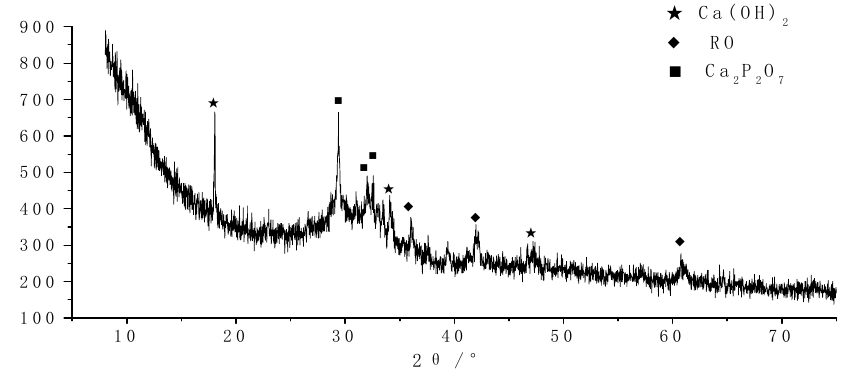
Figure 4. XRD diagram of 3 days of curing samples.